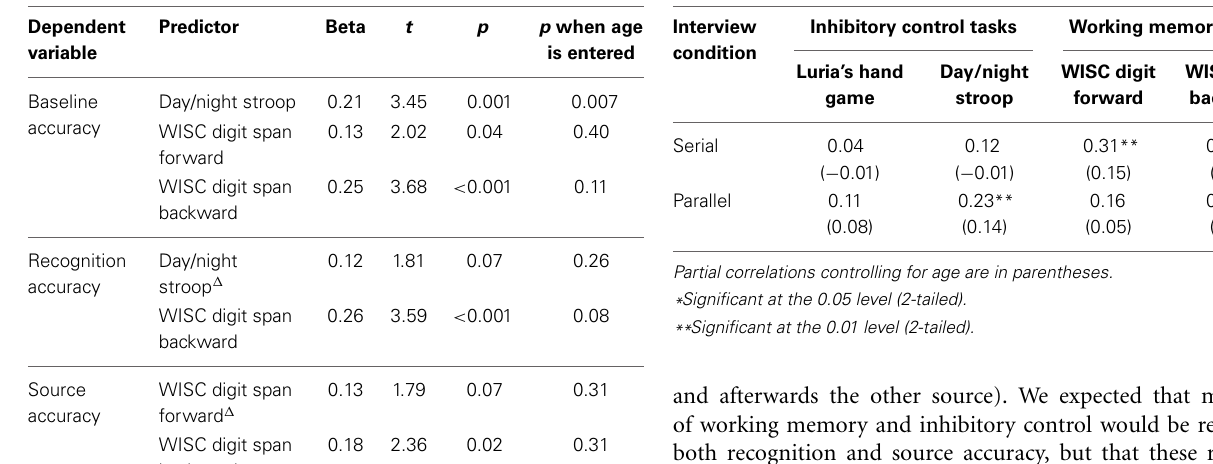
Table 5 | Standardized regression coefficients and test statistics for significant and marginal predictors in regression analyses.